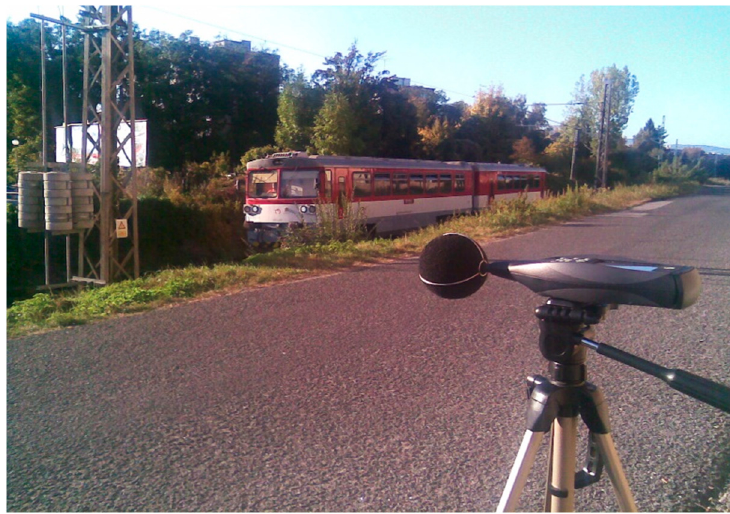
Figure 1. Measurement location “ZV“.